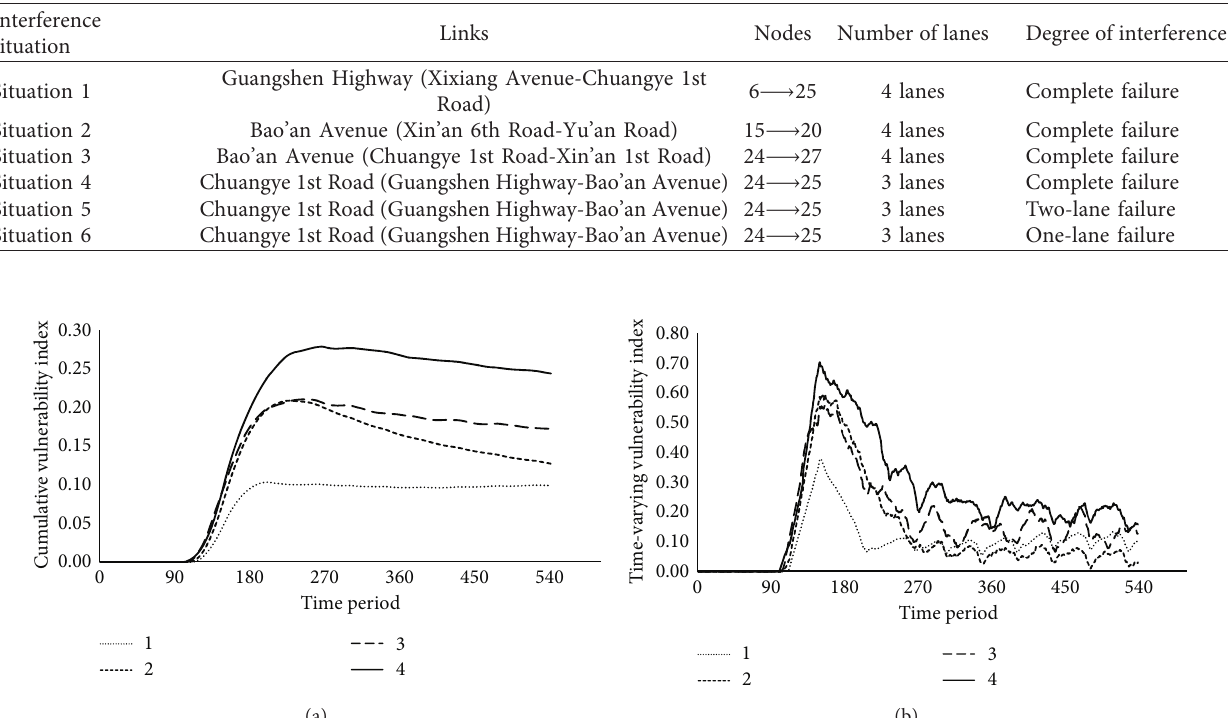
Figure 4: Example road network structure diagram. The left figure shows the actual layout of the road network in Bao’an Central Area, and the right figure shows that the abstraction is the road network structure. Table 1: Main interference situation setting